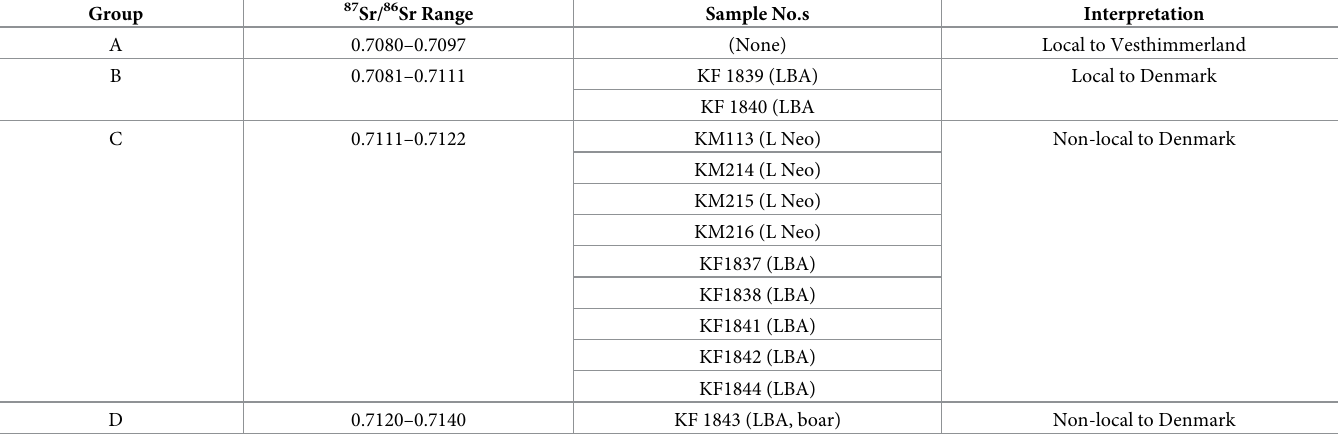
Table 7. Table showing comparative grouping of present data from Stenildg å rd, Vesthimmerland together with recent analysis of a nearby Late Neolithic grave from the same region [15]. Group 87 Sr/ 86 Sr Range Sample